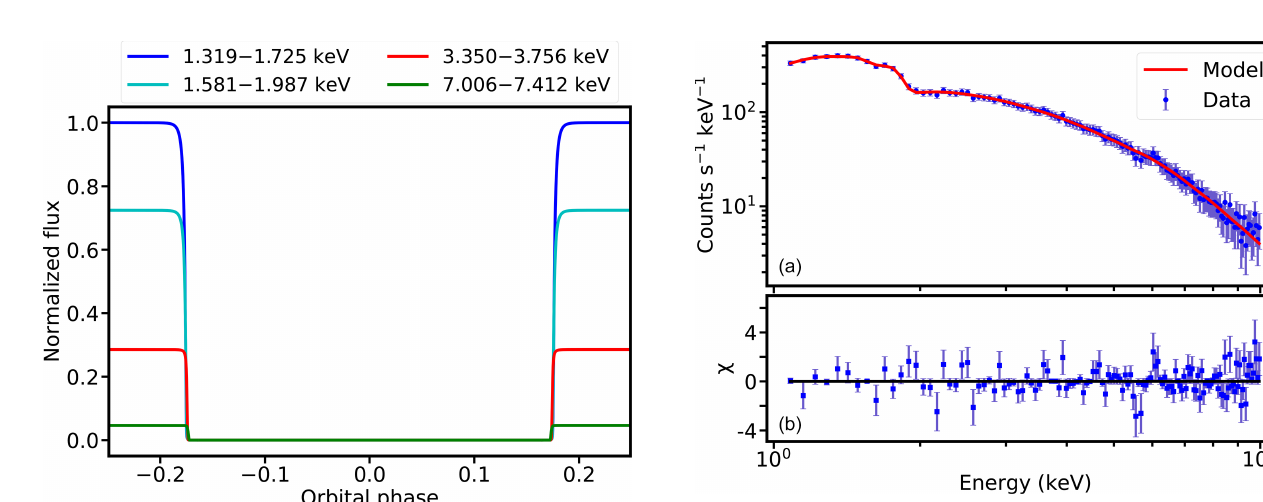
Figure 6. The schematic of light curve modelling of the X-ray Earth occultation.